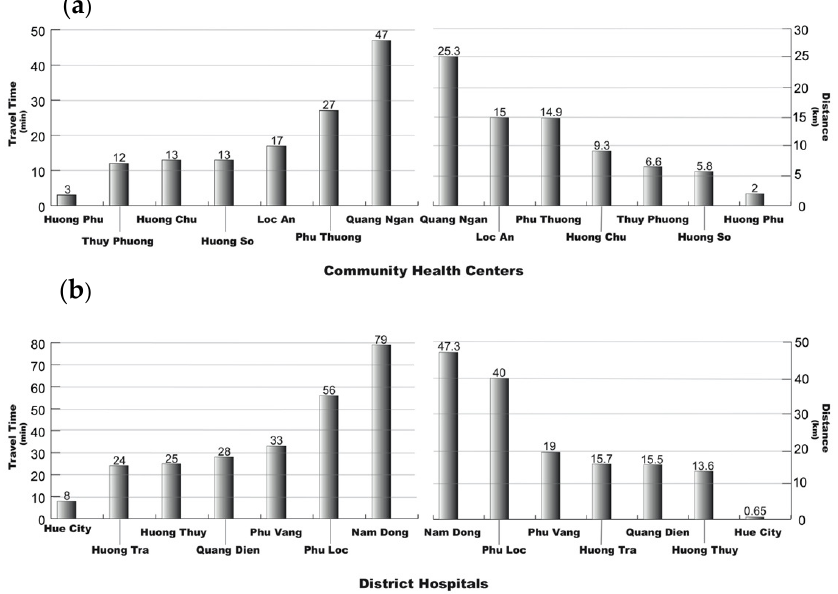
Figure 2. Travel time (min) and distance (km) from community health centers ( top ) and district hospitals ( bottom ) to their referral sites. ( a ) The top pareto plot of transport time ( left ) from the community health centers to either nearest district hospital, Hue University Hospital, or Hue Central Hospital. The corresponding distances for community health centers are shown as well ( right ). In rural regions such as Quang Ngan it took nearly fifty minutes for a patient to travel from the community health center to reach the referral site, whereas, in urban areas, travel time from Huong Phu community health center was less than five minutes to reach the referral site. ( b ) The bottom pareto plot shows the transport time ( left ) from the district hospitals to Hue University Hospital or Hue Central Hospital. The corresponding distances ( right ) for the district hospitals are shown as well. More mountainous regions such as Nam Dong took almost eighty minutes for a patient to travel from the district hospital to reach the referral site, whereas, in Hue City, patients traveled from their district hospital in less than ten minutes to reach the referral